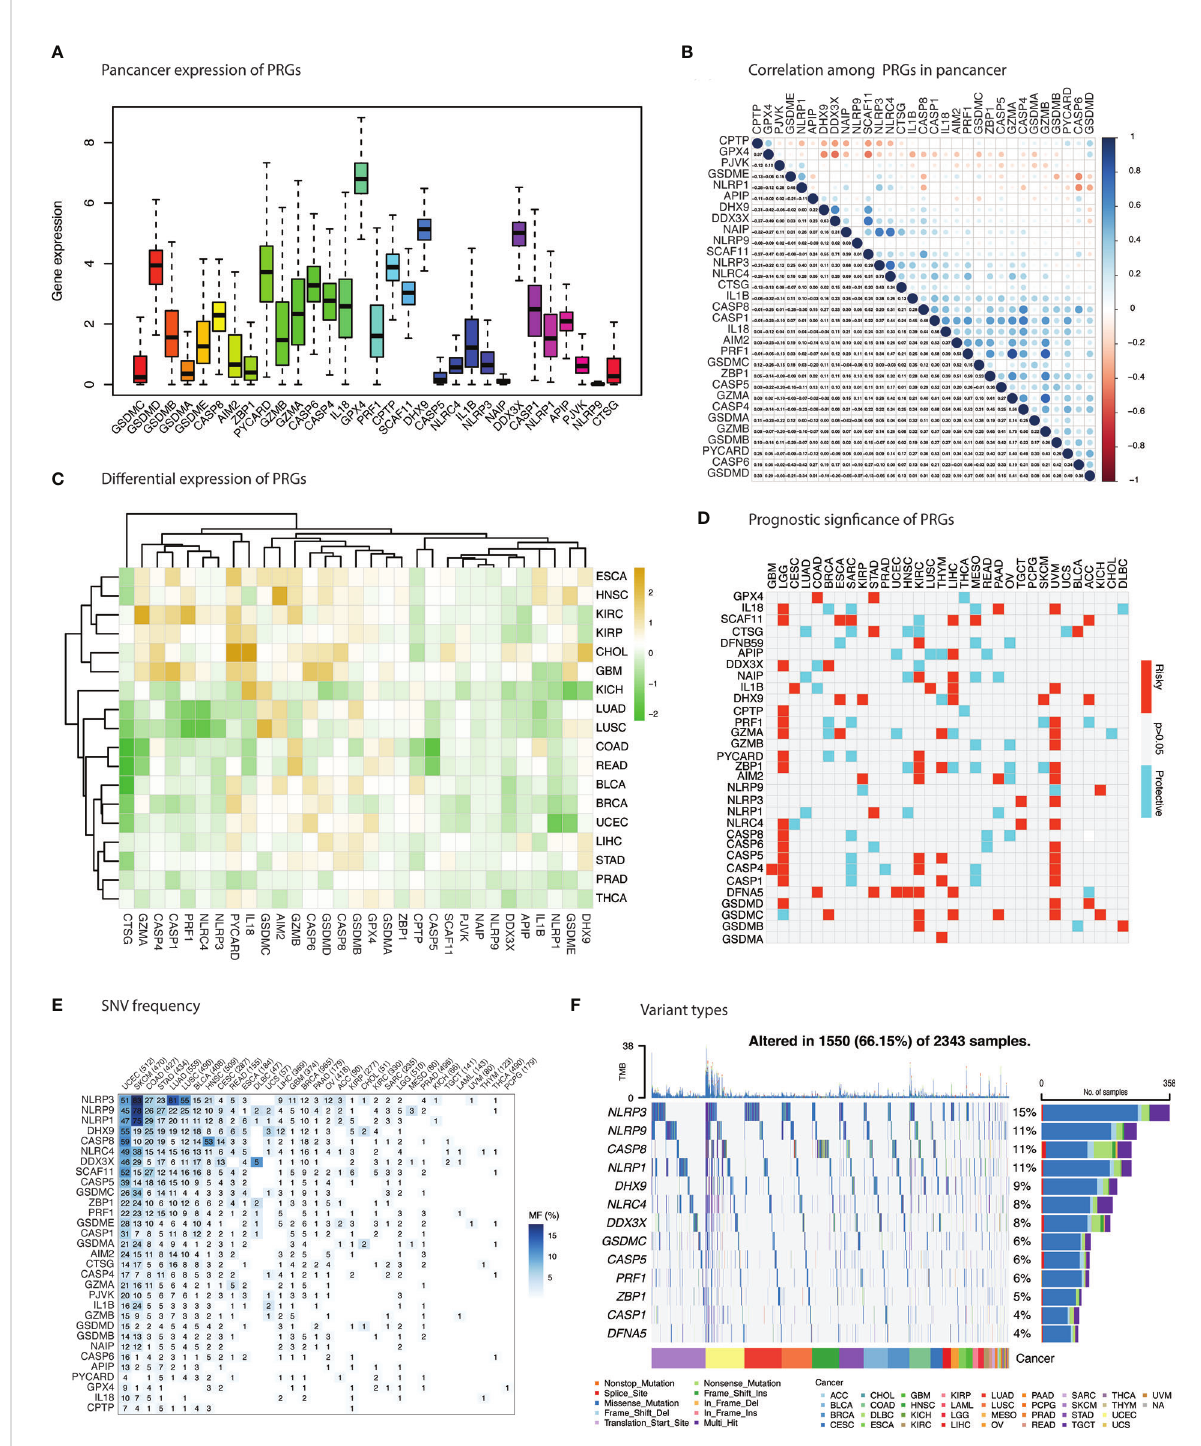
FIGURE 1 Differential expression, survival risk and mutations in pyroptosis-related genes (PRGs). (A) Cumulative expression of PRGs across cancers. (B) Correlation between PRGs in cancer. Blue indicate positive correlation and red indicate negative correlation. (C) Differential expression of PRGs in 18 cancers. Brown & green represent upregulation & downregulation of PRGs in cancers respectively. (D) Survival risk of PRGs. Red and blue indicate risky and protective effect of PRGs enrichment. (E) Histogram shows the frequency of single nucleotide variation for each PRG in each cancer type. (F) Oncoplot depicting top 10 mutated PRGs in